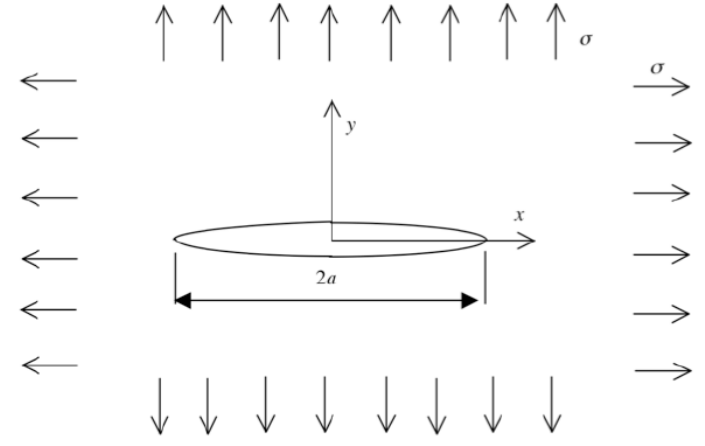
Figure 2. Mode I stress under bi-axial loading [16].